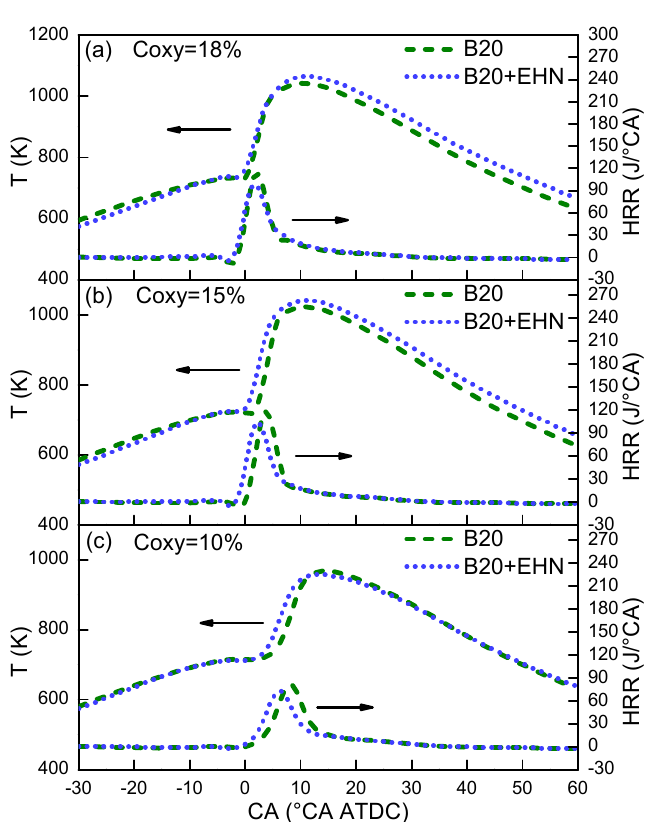
Figure 8. Average in-cylinder temperature and heat release rate at 18% ( a ), 15% ( b ), and 10% ( c ) intake oxygen concentrations.